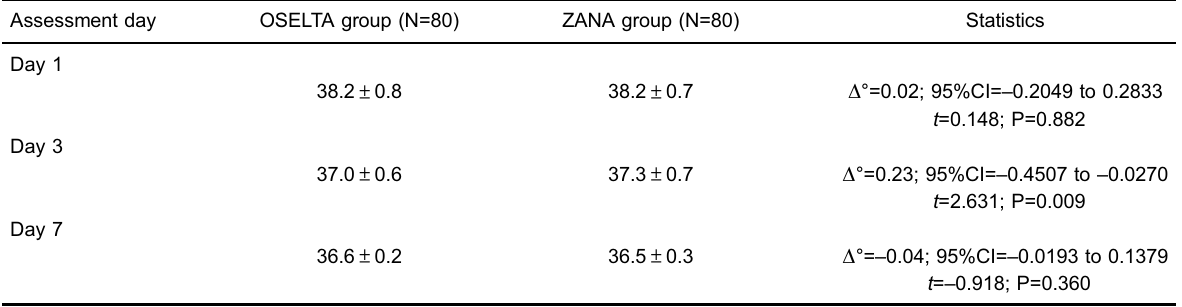
Table 2. Changes in body temperature (°C) on days 1, 3, and 7 of treatment of chronic obstructive pulmonary disease patients with in fl uenza virus infection treated with oral oseltamivir (OSELTA group) or inhaled zanamivir (ZANA